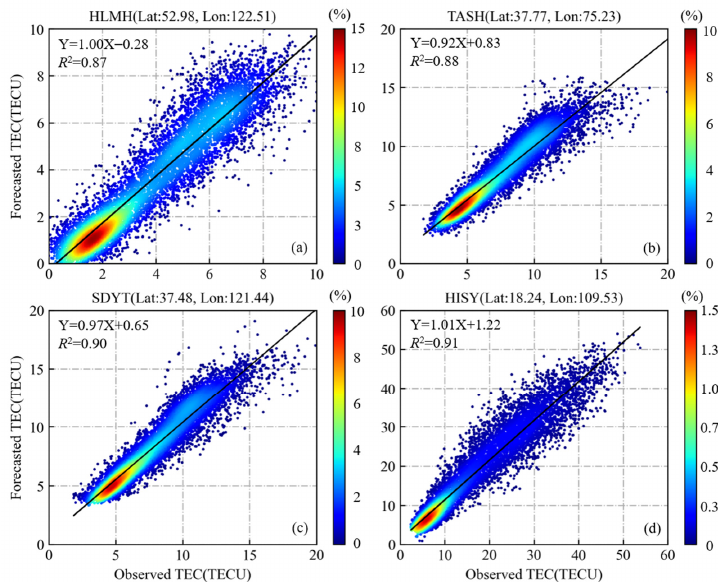
Figure 5. Scatterplot of forecasted TEC as a function of observed TEC for the ( a ) HLMH, ( b ) TASH, ( c ) SDYT, and ( d ) HISY stations. The horizontal axis is the observed TEC; the vertical axis is the forecasted TEC, and color represents percentages.